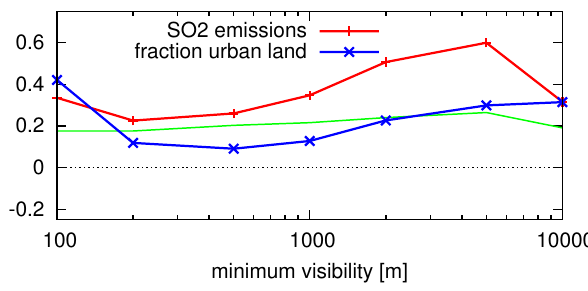
Fig. 3. Spatial rank correlation of the trend in the annual number of days with minimum visibility less than a range of cut-offs with the trend in EMEP SO 2 emissions 1990–2007 (Streets et al., 2006) and with the trend in the fraction of urban land (Hurtt et al., 2006) (with sign changed) on a 2.5 ◦ × 2.5 ◦ grid covering 10 ◦ W–35 ◦ E, 37 ◦ – 60 ◦ N. The green line indicates the correlations that have p =0.05, using a number of degrees of freedom deduced from the spatial au- tocorrelation.